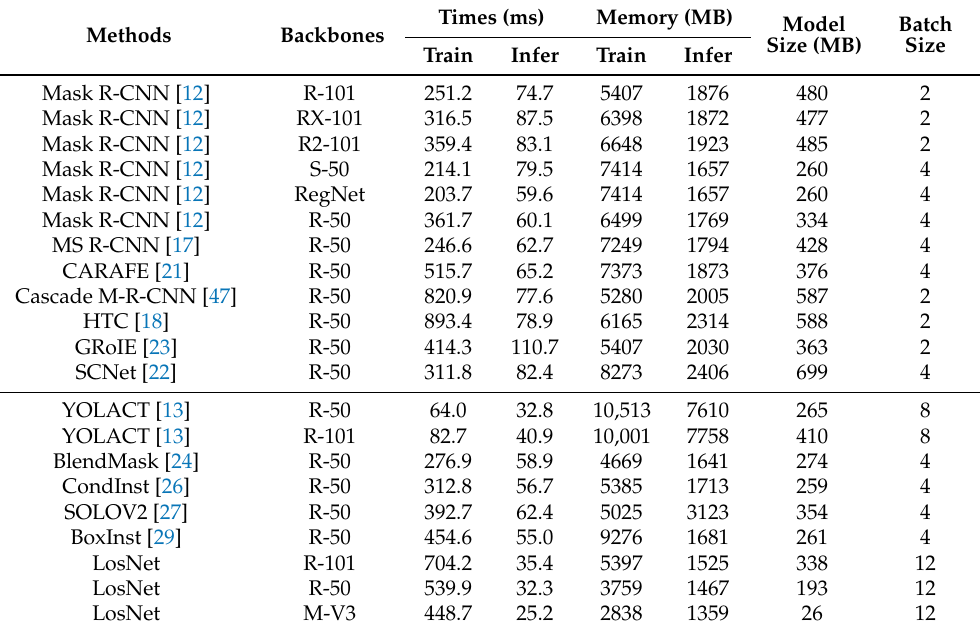
Table 8. Comparison of the speed, memory, and model size with the state-of-the-art methods on ore image